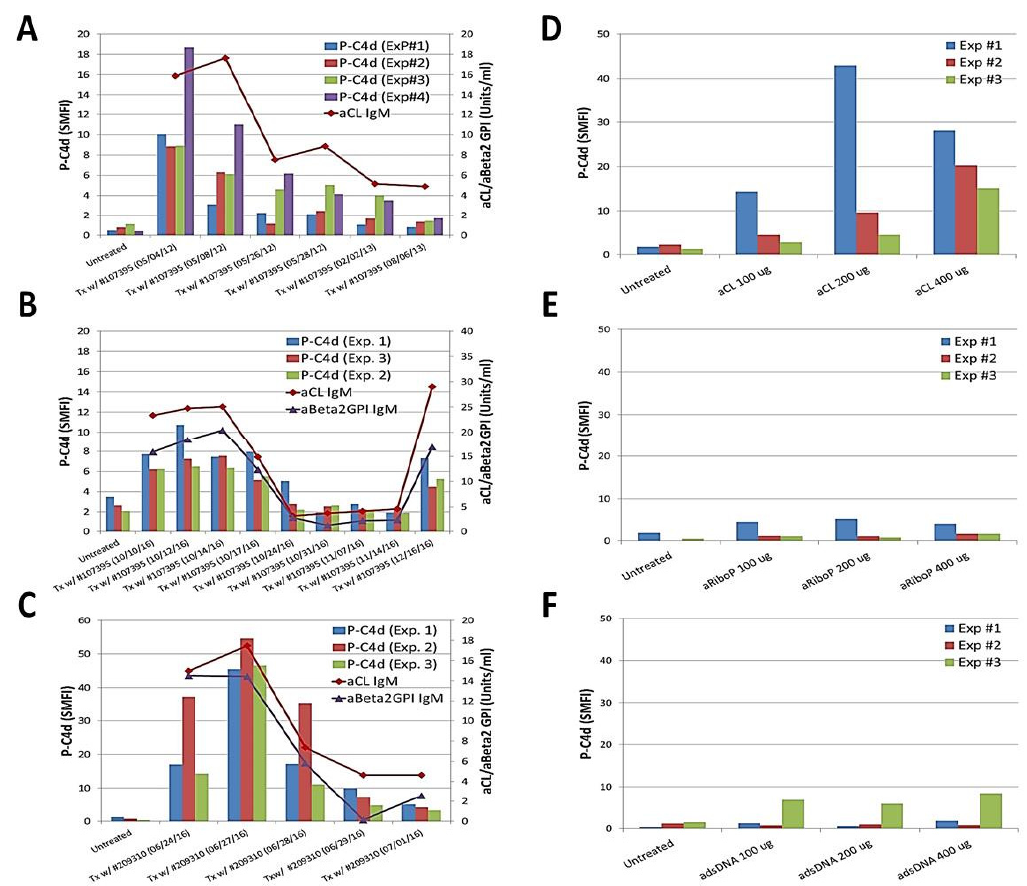
Figure 2. Participation of anti ‐ phospholipid antibodies in generating the P ‐ C4d phenotype in vitro.